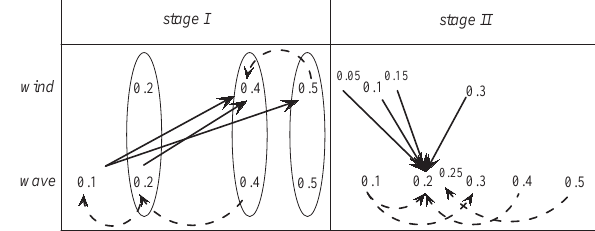
Fig. 11. Schematic of major energy transfers in stages I and II: oval link: between the wind and waves through linear coupling; solid arrow: between the wind and waves through nonlinear coupling; dashed arrow: within the wind or the waves through nonlinear cou- pling; unit of the frequencies: